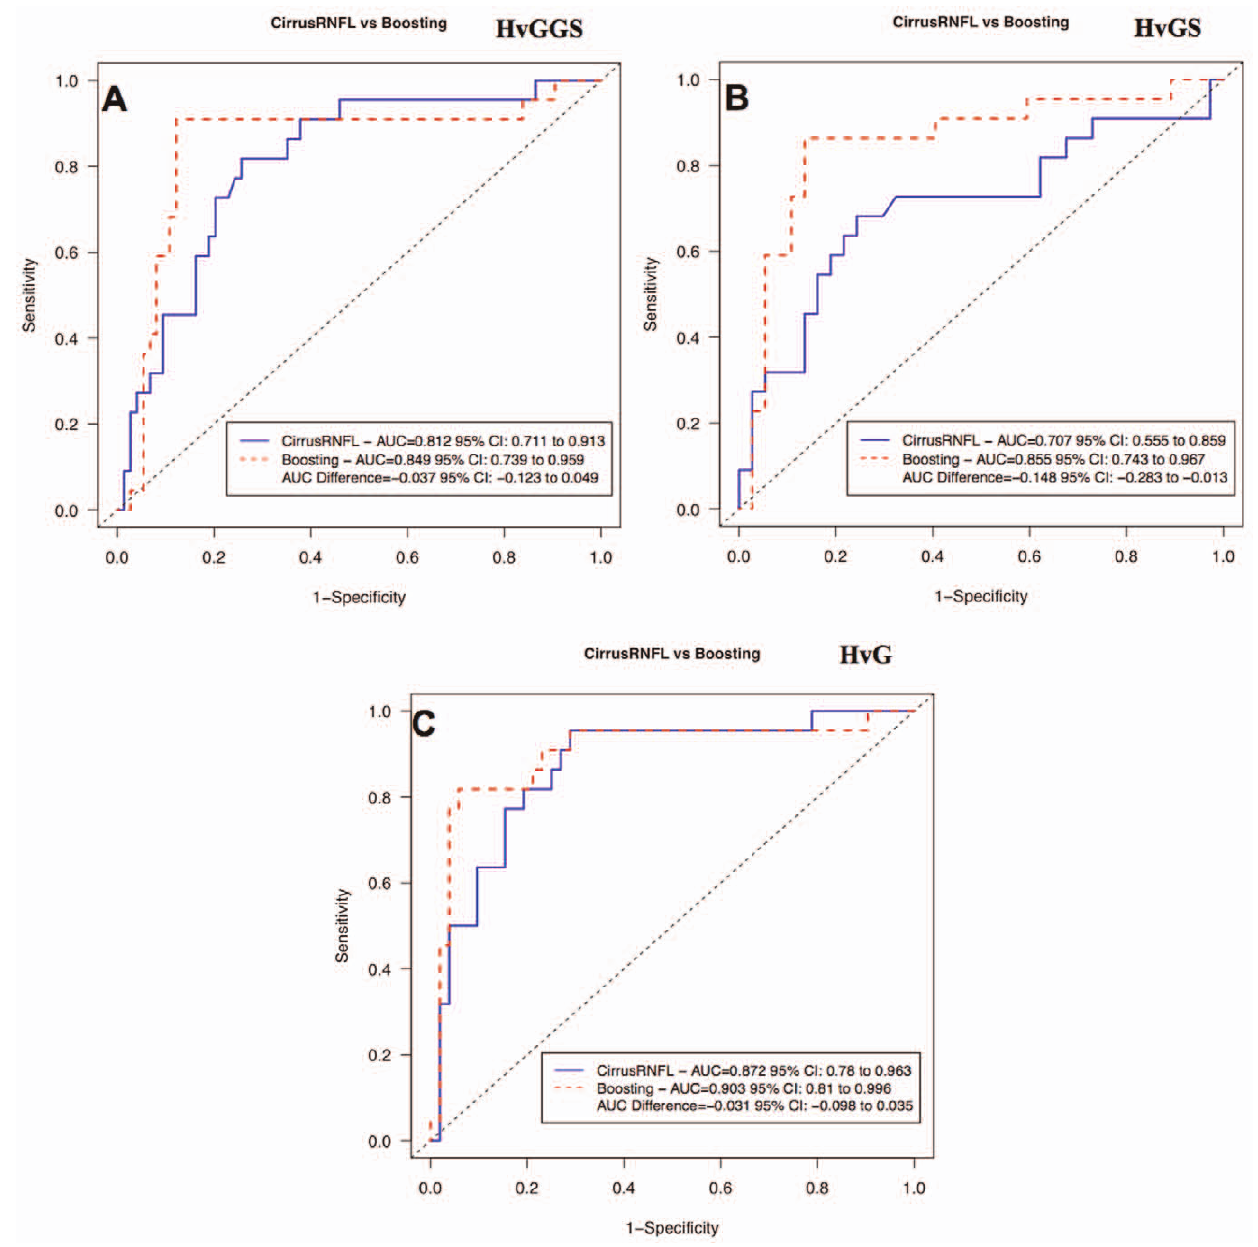
Figure 6. The receiver operating characteristic curves (ROCs) computed with the machine classifier method and Cirrus HD-OCT software generated mean cpRNFL thickness. (H) healthy eyes, (G) glaucomatous eyes, (GS) glaucoma suspect eyes.